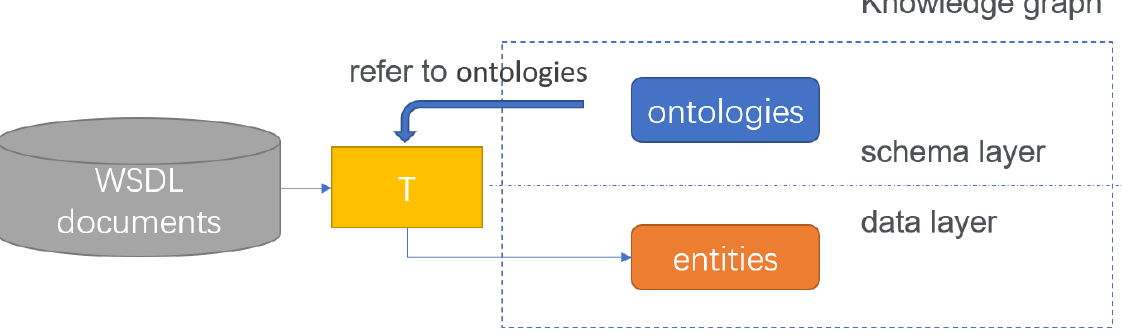
Figure 5. The method of constructing knowledge graph. T represents a series of translation modules. Designed ontologies form the schema layer of the knowledge graph. The translation module designed with reference to the ontologies converts WSDL documents into service entities and stores them in the knowledge graph.